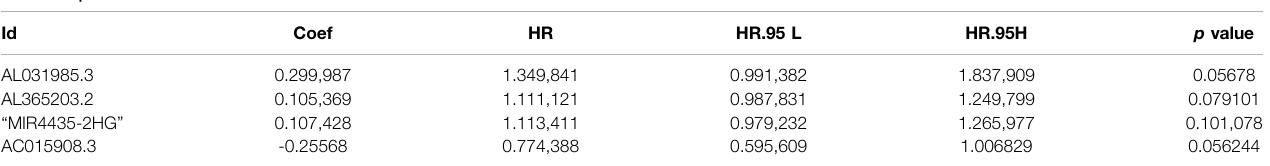
TABLE 2 | Multivariate Cox results of lncRNAs based on TCGA-LIHC data. Id Coef HR HR.95 L